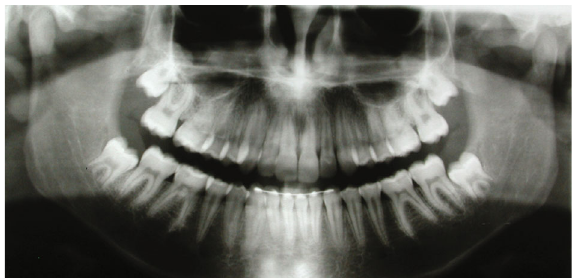
Figure 8: Final panoramic